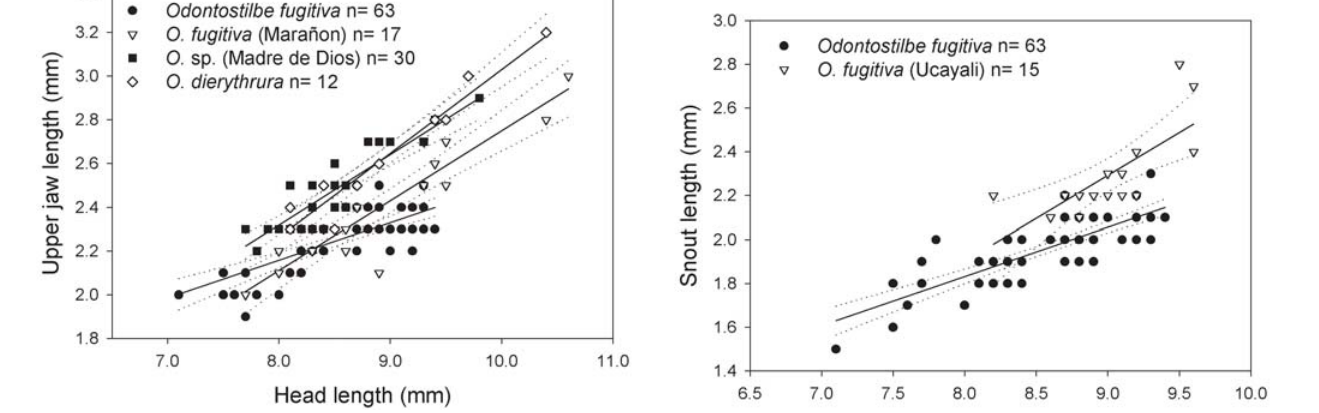
Fig 9. Upper jaw length as a function of head length for males of Odontostilbe fugitiva , specimens widely distributed on rio Amazonas, and upper and middle río Maranõn basin, against O. dierythrura and Odontostilbe sp. of río Madre de Dios basin.